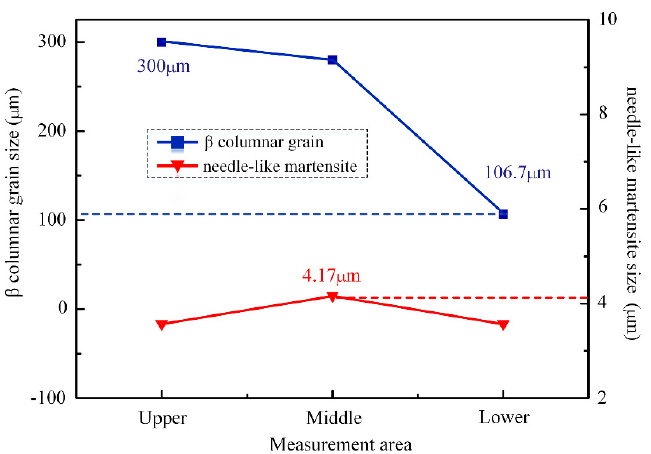
Figure 8. Results of quantitative analysis on the microstructure of the weld zone between layers in different areas of the joint.